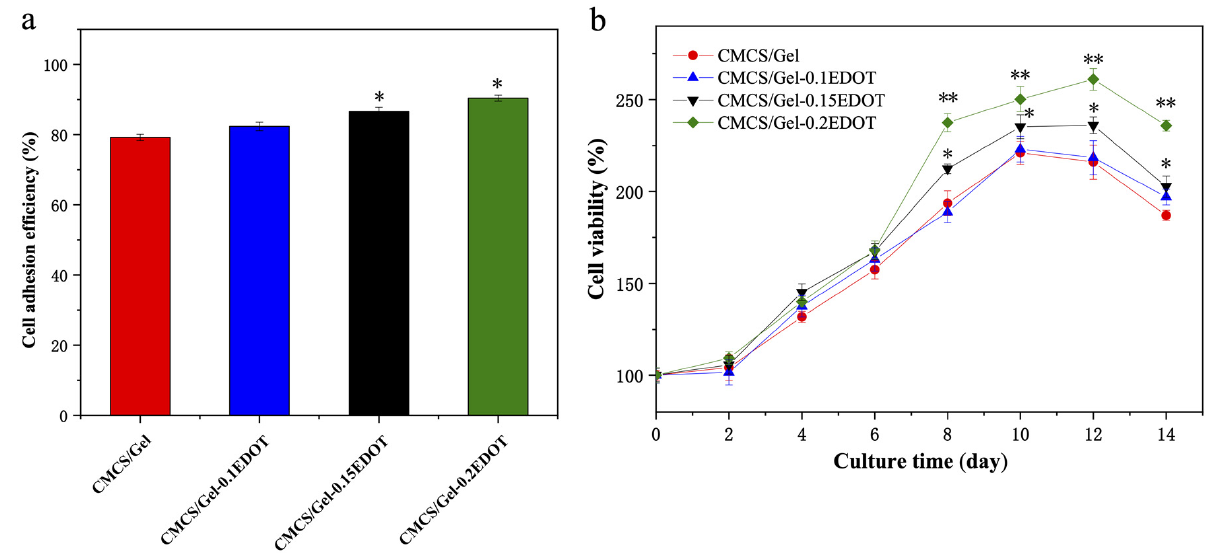
Figure 7. Cell adhesion efficiency ( a ) and proliferation ( b ) of NSCs in CMCS/Gel and CMCS/Gel- PEDOT hydrogels. Data are mean ± SD values obtained from four culture wells per experiment, determined in three independent experiments, and (*) p < 0.05, (**) p < 0.01, statistically different from the CMCS/Gel group.